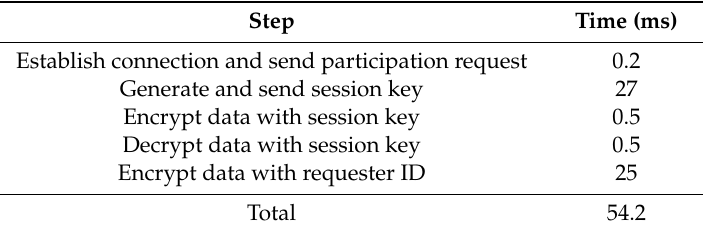
Table 7. Average time required to provide sensing